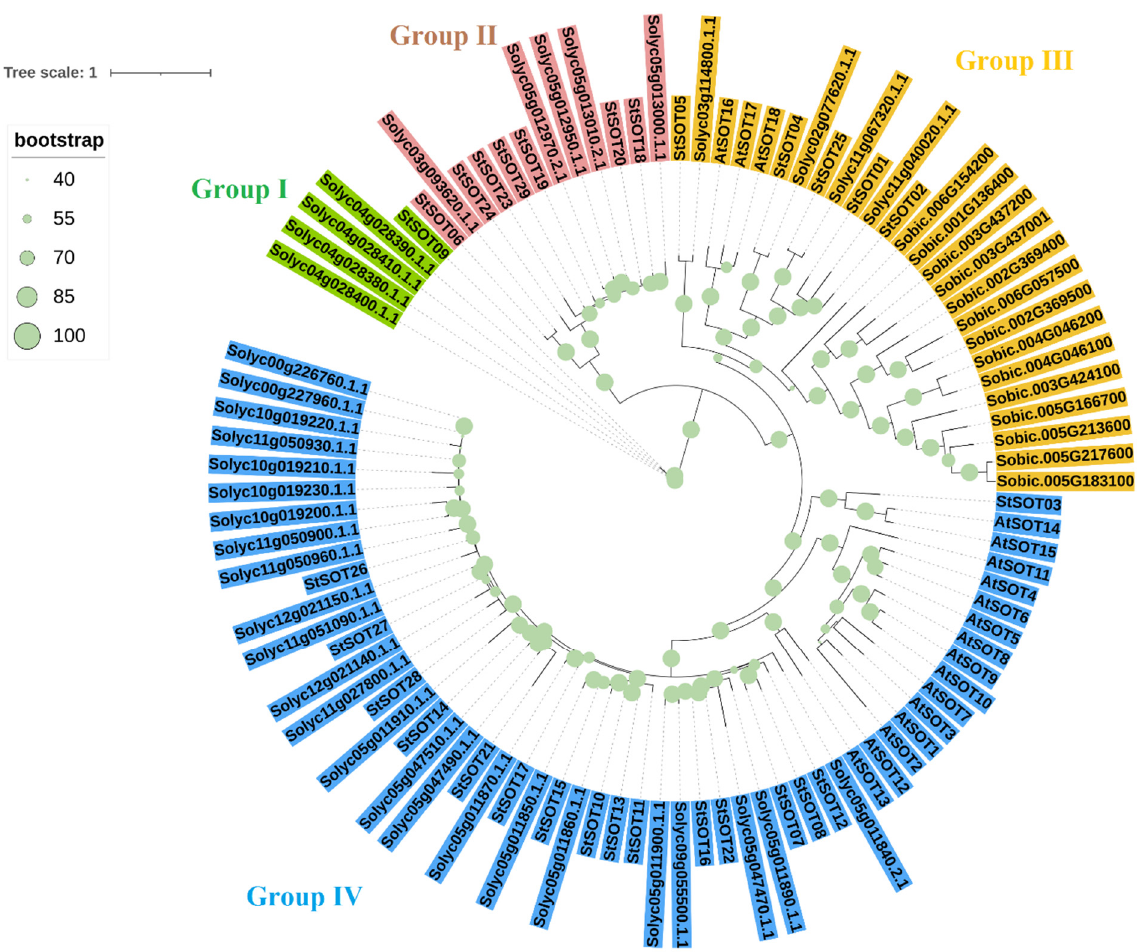
Figure 2. Phylogenetic relationships of SOT proteins from potato, tomato, Arabidopsis , and sorghum. The four main clusters were detected based on the ML method in the phylogenetic tree. Abbreviations: St, potato; Solyc, tomato; Sobic, sorghum; At, Arabidopsis.